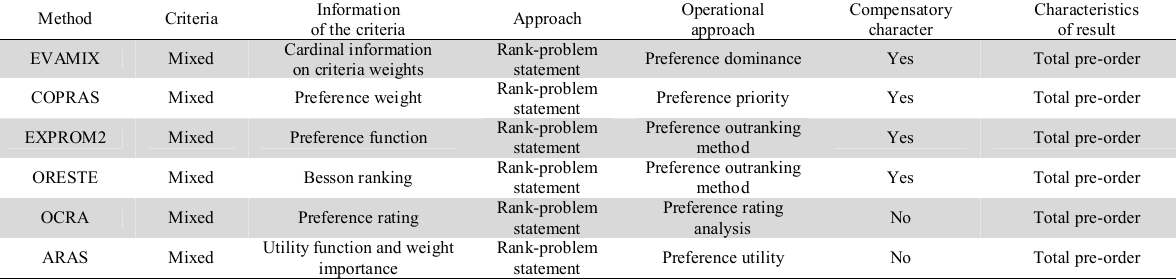
Characteristics of the six preference ranking